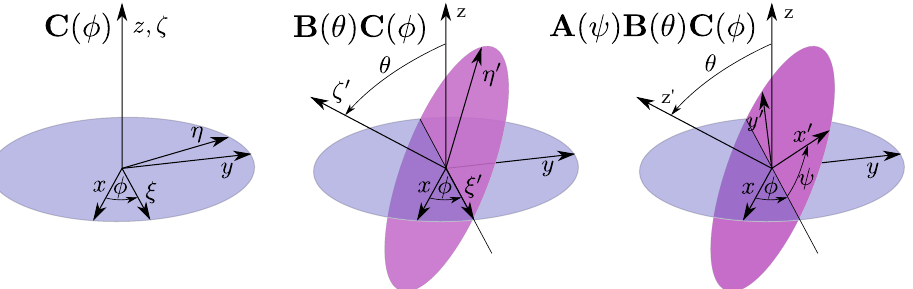
Figure A1. Definition of the Euler angles describing an arbitrary 3D rotation, for which the reference frame ( x , y , z ) was transformed into ( x (cid:48) , y (cid:48) , z (cid:48) ) by applying the rotation matrix R ( φ , θ , ψ )